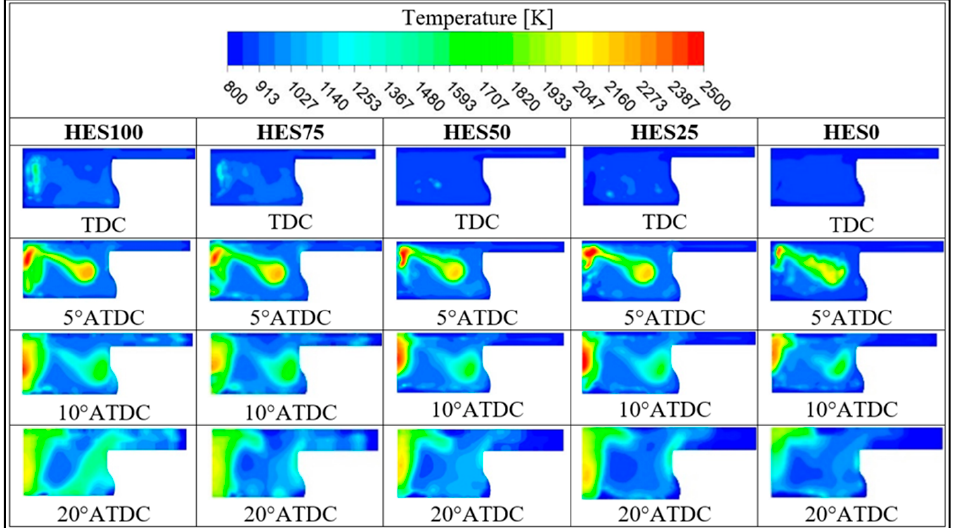
Figure 22. Temperature distributions for the different HES cases .